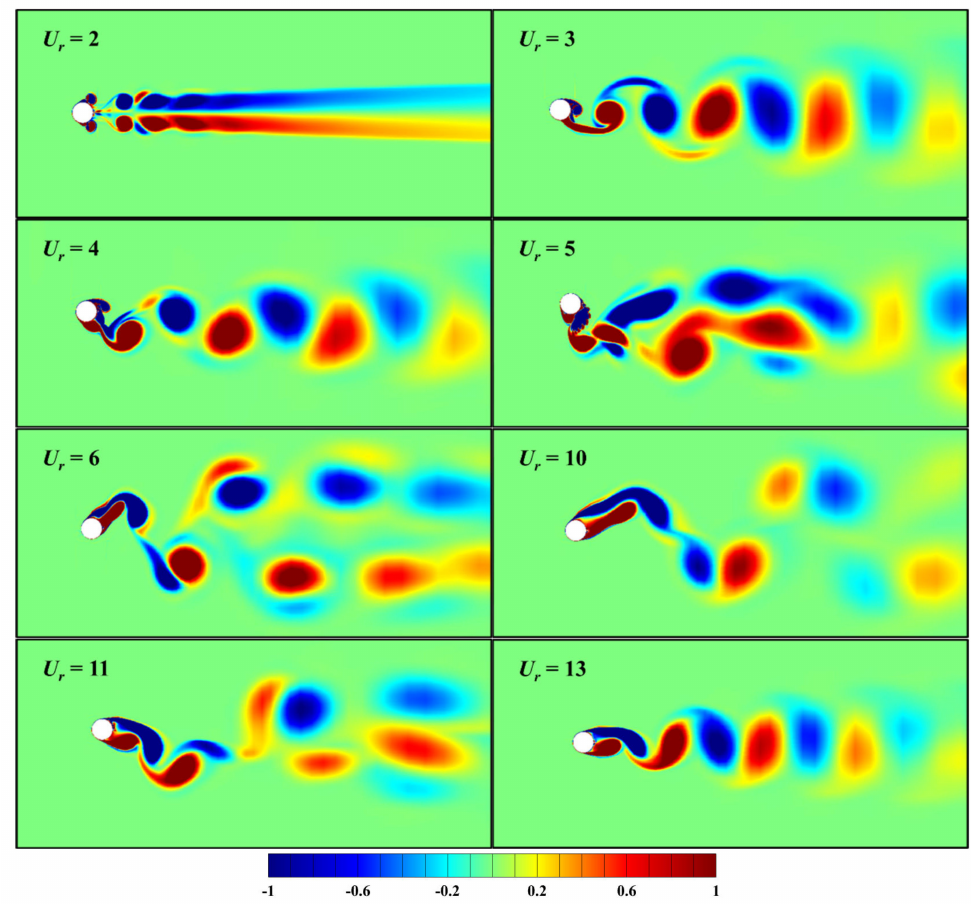
Figure 14. Instantaneous vorticity field for two coupled cylinders at α = 0 ◦ and d/D =